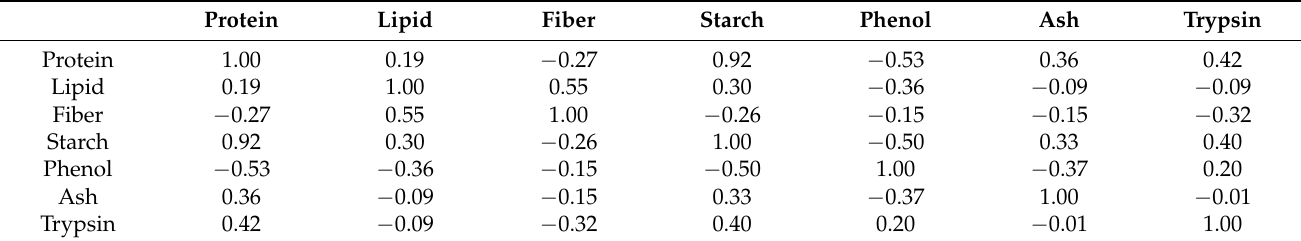
Figure 2. Scatter plot of protein content (g/100 g dry matter) versus starch content (g/100 g dry matter). Table 4. Correlation analysis between nutritional and antinutritional variables .